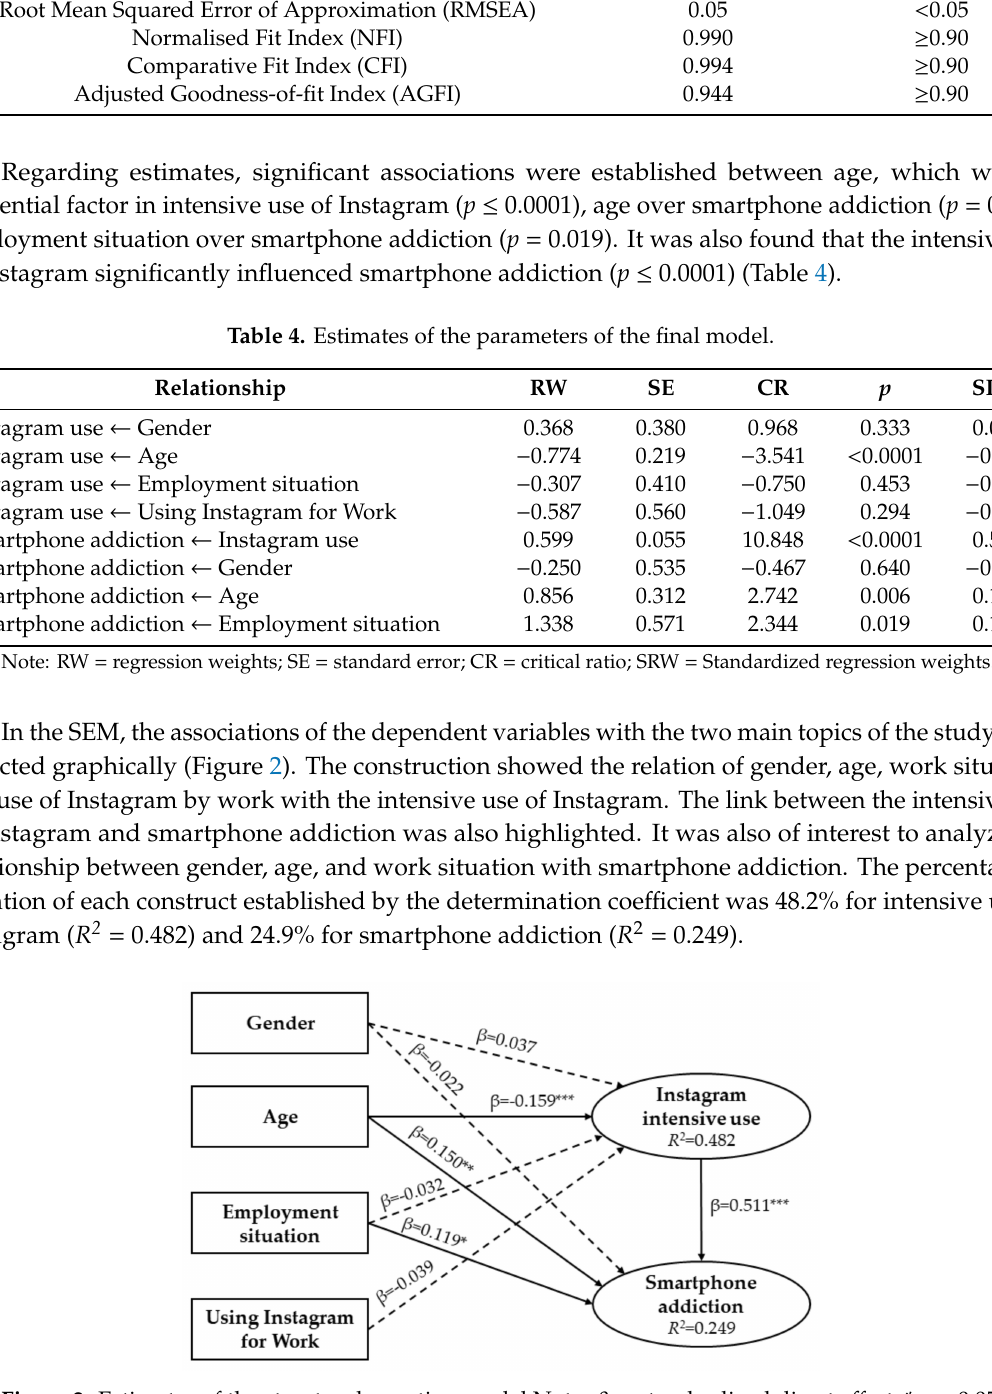
Figure 2. Estimates of the structural equation model Note: β = standardized direct e ff ect; * p < 0.05; ** p < 0.01; *** p < 0.001. Discontinuous arrow = not